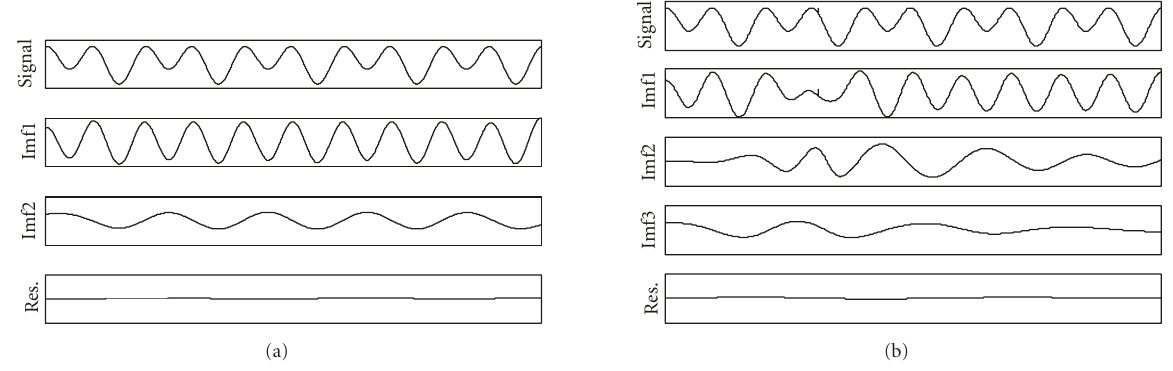
Figure 1: (a) The decomposed results of formula (2) and (b) the decomposed results of signal with intermittency signal.